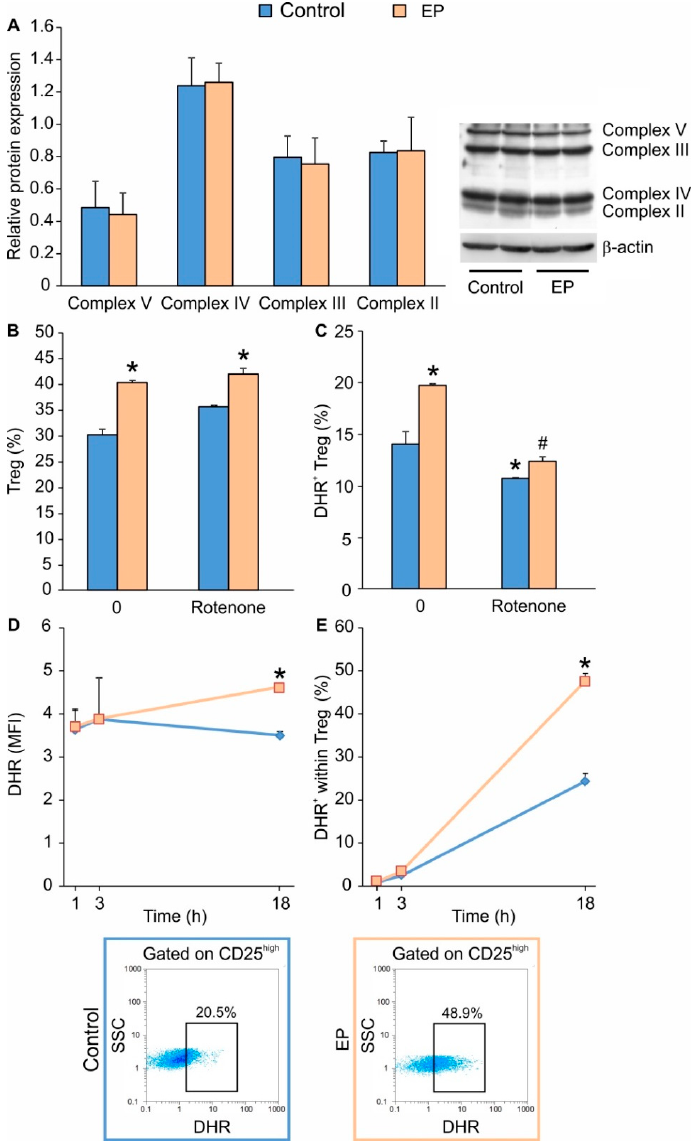
Figure 3. The effect of EP on oxidative phosphorylation (OXPHOS) and ROS production in differentiating Treg. ( A ) Relative protein expression of mitochondrial transport chain complexes 72 h after EP administration. The impact of rotenone (simultaneously applied with EP) on ( B ) EP-driven Treg (CD4 + CD25 high FoxP3 + ) proportion or ( C ) ROS formation, measured by dihydrorhodamine 123 (DHR) staining. ( D ) Timeline of ROS production per Treg (CD4 + CD25 high ) and ( E ) the proportion of ROS-producing Treg in control and EP-treated cells. Representative dot plots are shown below the graph. * p < 0.05 represents the significant difference of EP- or rotenone-treated cells in comparison to untreated control cells, while # p < 0.05 represents the significant difference between rotenone+EP- treated cells in comparison to EP-treated cells.